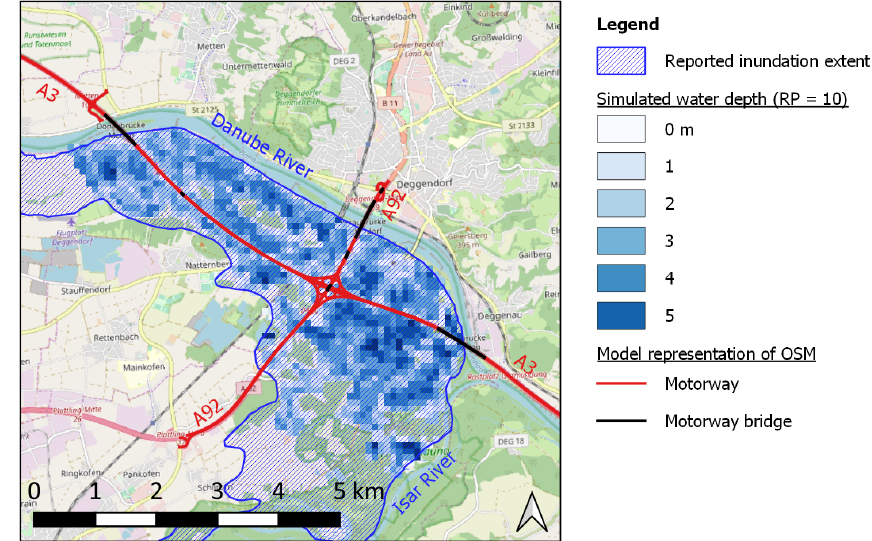
Figure 8. Observed and simulated flood in Deggendorf. Simulated map according to the cropped return period (RP) of the 10-year flood map (Alfieri et al., 2015). Background map © OpenStreetMap contributors 2019. Distributed under a Creative Commons BY-SA